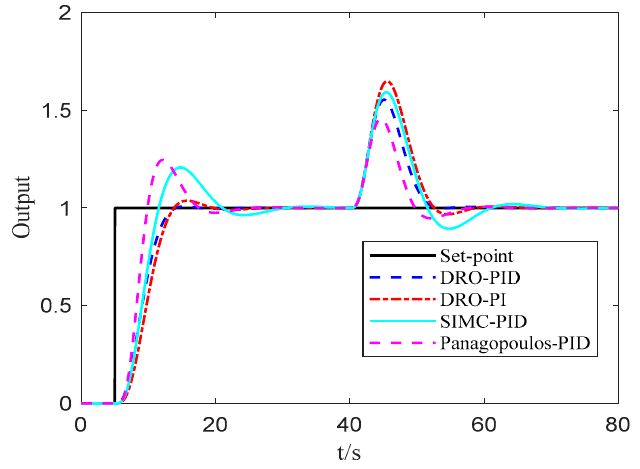
Figure 4. The output response of the step set-point and input disturbance for Example 1.